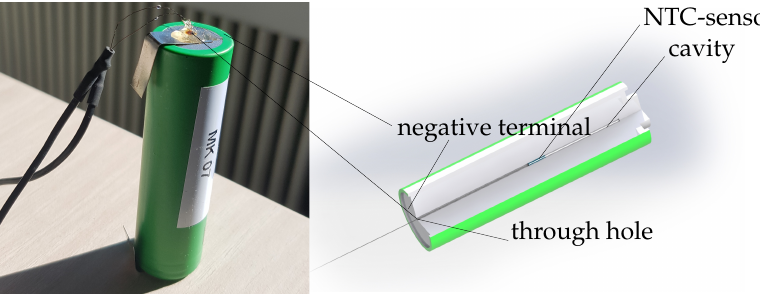
Figure 1. LIBC equipped with temperature sensor. On the left is a photograph of the prepared cell. On the left is a sectional view of sensor placement in LIBC. The figure shows the production-related cavity with an NTC-sensor placed in the middle. The cavity is accessed by a through-hole in the center of the negative terminal.